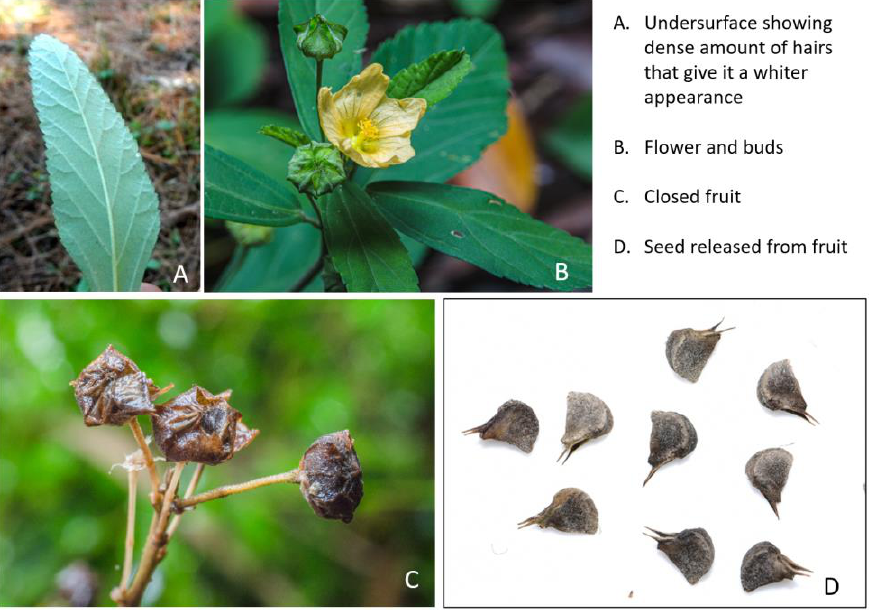
Figure 1. The morphological photographs of tested S. rhombifolia showing the leaves, flowers, fruits, and seeds released from fruits.